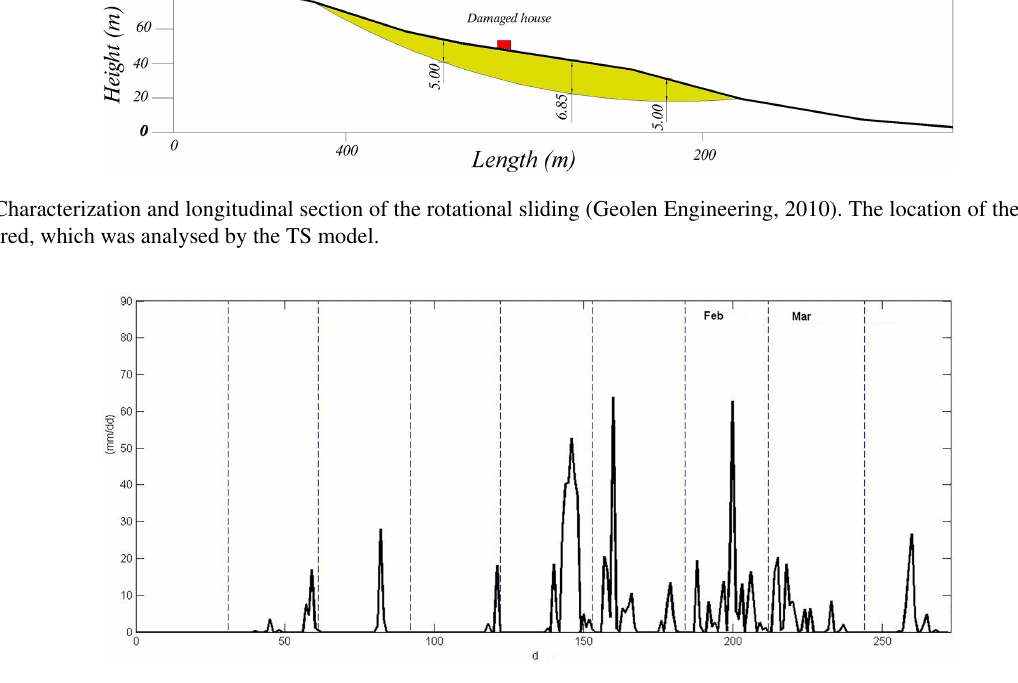
Figure 10. Rainfall histogram at La Viñuela from August 2009 to April 2010. Rainfall data have been provided by the Spanish Meteorological Agency (station of Viñuela).